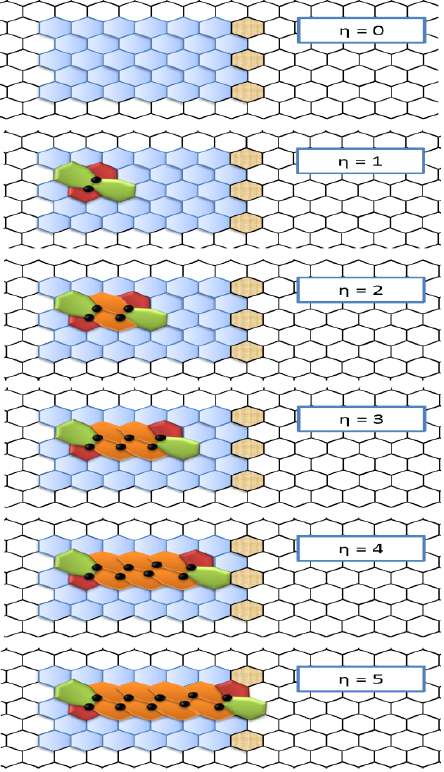
Figure 2. Propagation of the Stone-Wales wave-like defect along the zig-zag direction caused by the insertion of pairs of hexagons at η = 1, corresponding to the SW defect generations step; the size of this dislocation dipole ranges from η = 0 (pristine lattice) to η = 5; pristine (rearranged) hexagons are in blue (and orange); pentagons and heptagons are in red and green,